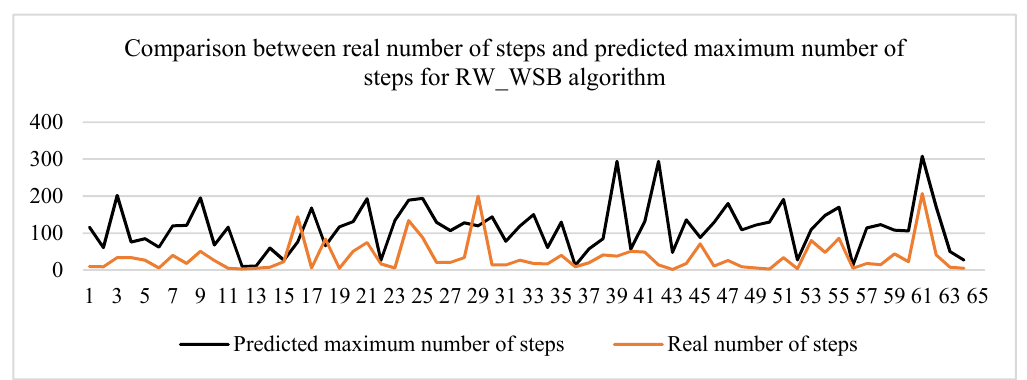
Figure 12. Comparison between real number of steps and predicted maximum number of steps for RW_WSB algorithm.